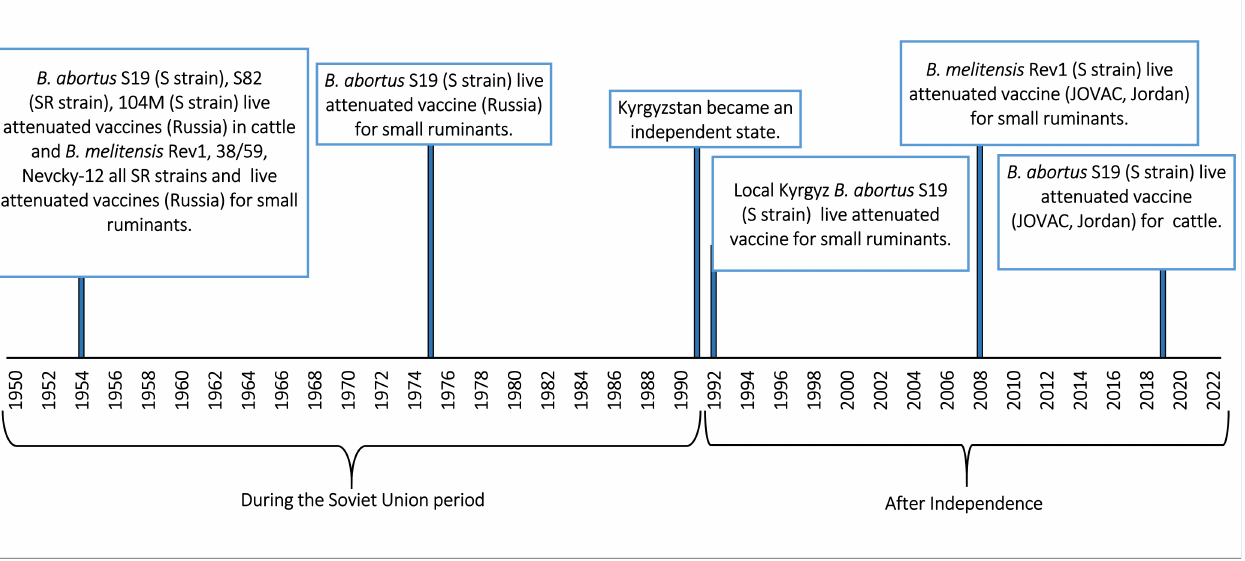
Figure 5. Timeline of vaccines used in Kyrgyzstan from 1950 to 2021. Adapted from Kasymbekov J. (2014), Ivanov A. V. (2011), Albertian M. P. (2006), personal communication Abdyraev M. (Duisheev KRIV); on 28 December 2021 [30,34,35].